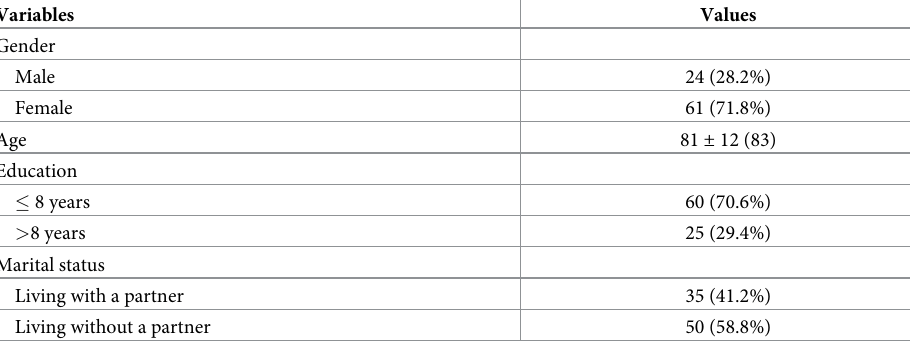
Table 1. Baseline demographic characteristics of the study